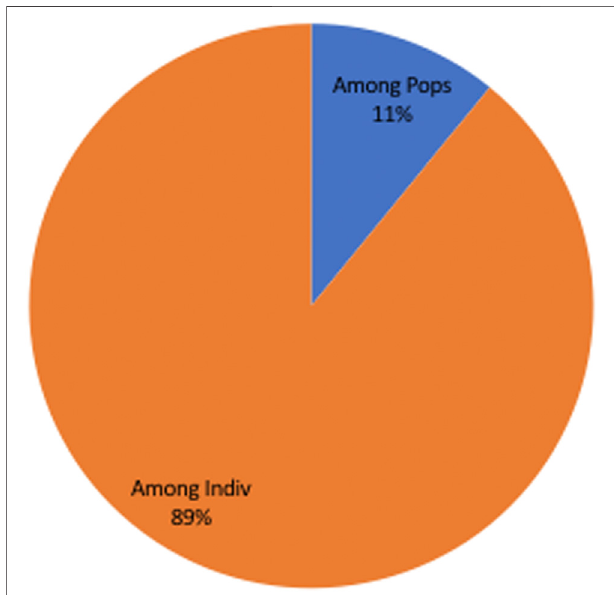
fact that population differences account for the majority of genetic variety (89%) observed within